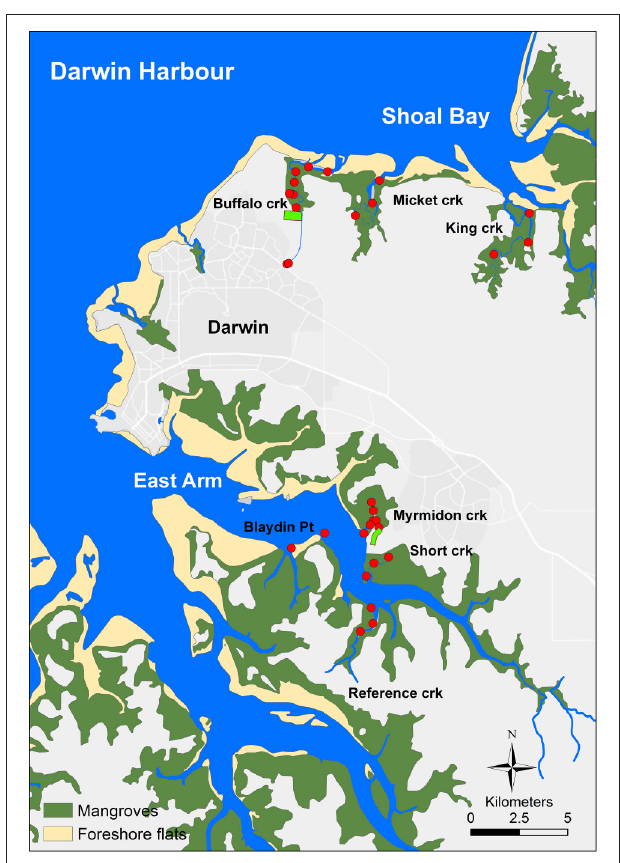
FIGURE 1 | The Darwin Harbour map. Darwin Harbour in northern Australia with sampling sites in Shoal Bay and East Arm. The light green rectangles at Buffalo and Myrmidon Creek indicate the wastewater treatment